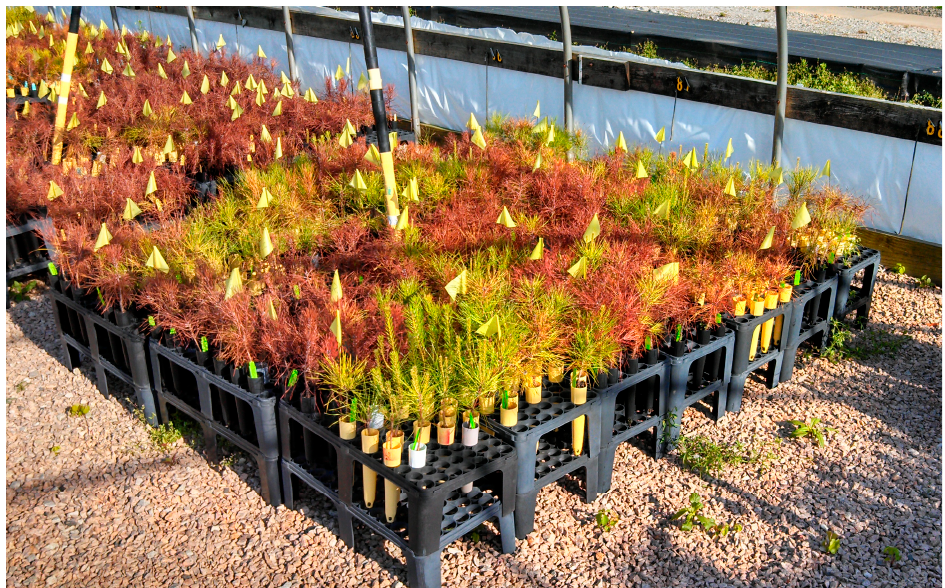
Figure 32. After the wind destroyed a protective plastic cover, rooted cuttings of loblolly pine were killed by a 30 January 2014 freeze ( − 13 °C). Although average survival was 30%, one northern genotype had 80% survival [204]. Reproduced with permission from Steve McKeand [204].